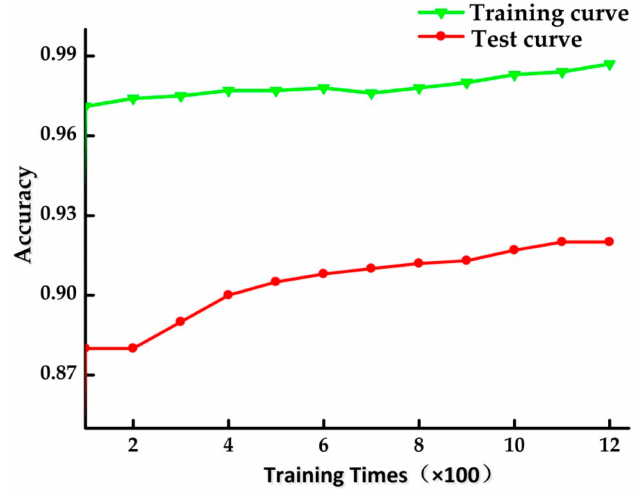
Figure 12. The accuracy curve of built